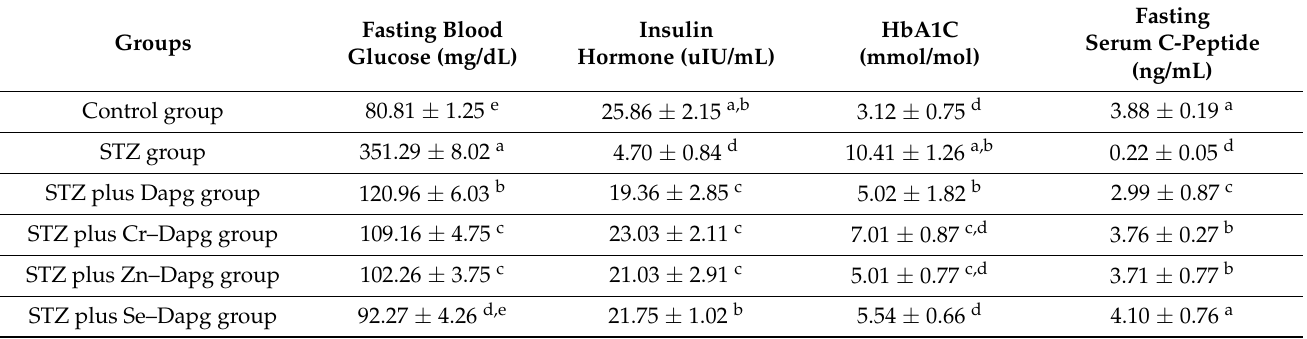
Table 2. Fasting blood glucose level, insulin hormone, HBA1C and fasting serum C-peptide results.